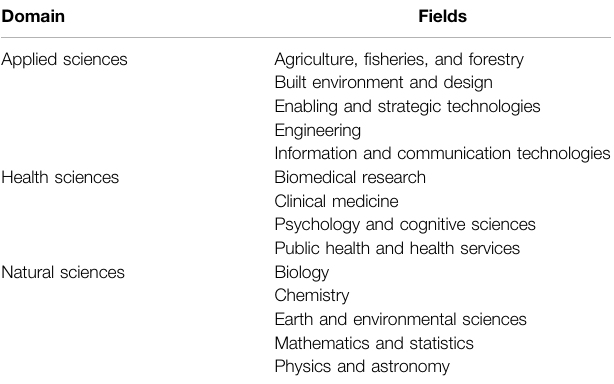
algorithmic techniques and expert judgment (Ronda-Pupo